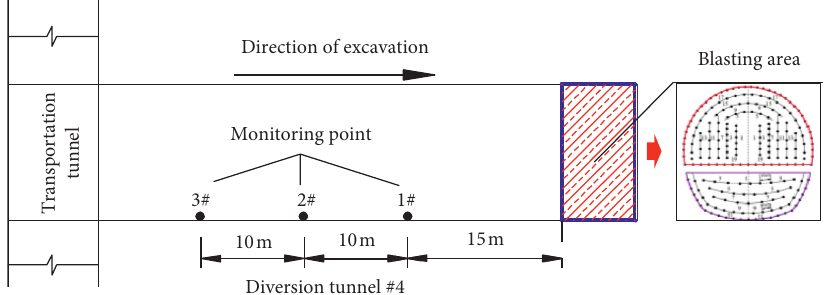
Figure 3: Layout of blasting vibration monitoring of diversion tunnel #4 for the Jinping II hydropower station.